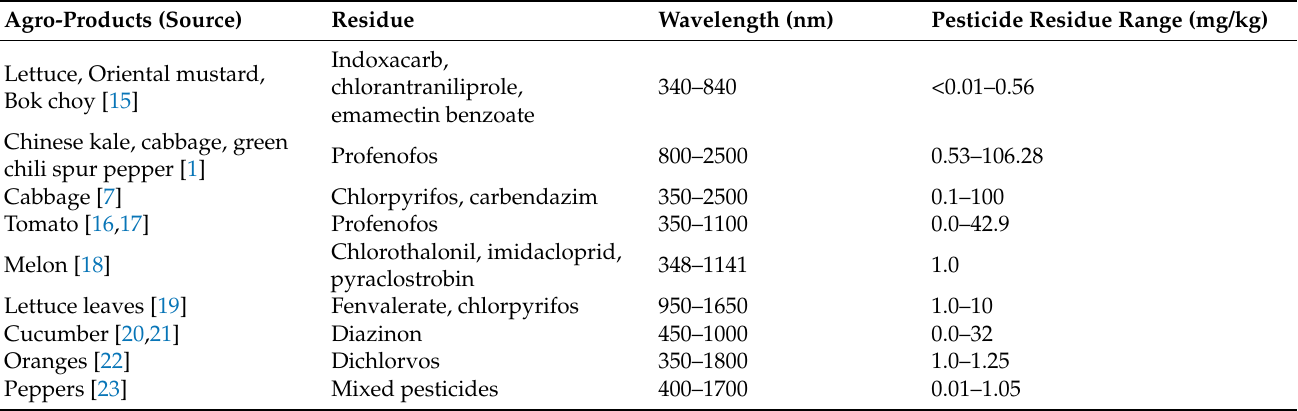
Table 1. Summary of studies employing Vis and NIR spectroscopy to detect pesticide residue on horticultural